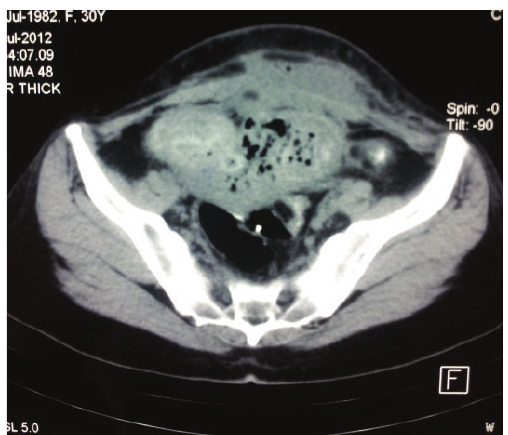
Figure 1: A CT scan showing retained surgical sponge next to the uterus.